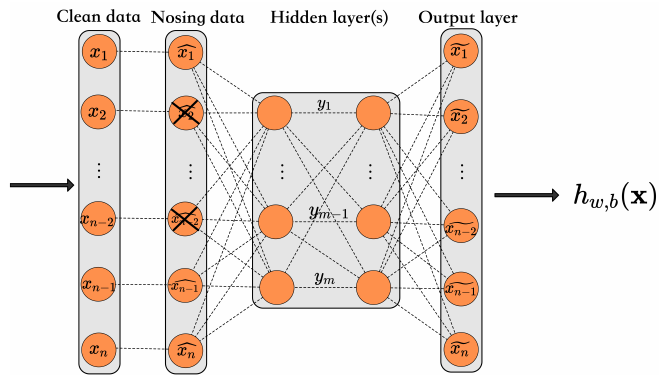
Figure 5. Denoising